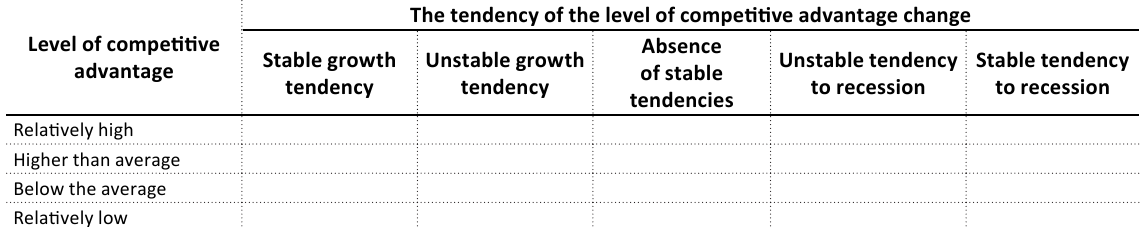
Table 3. The matrix of the choice of the basic guidelines for the water resources management system at the territorial